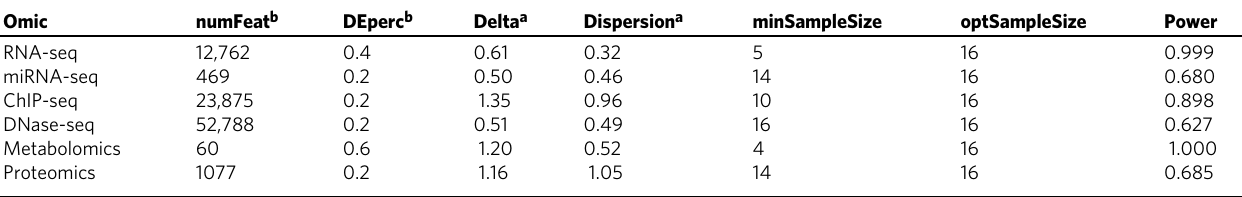
MultiPower results were obtained for the same sample size in all technologies, a minimum power per omic of 0.6, a minimum average power of 0.8, and a Cohen ’ s d of 0.8. numFeat number of omic features, DEperc expected proportion of DE features, delta difference of means to be detected, dispersion pooled standard deviation, minSampleSize sample size to achieve the minimum power per omic, optSampleSize optimal sample size for the experiment, power power reached with the optimal sample size. a Parameter estimated by MultiPower. b Parameter provided by the